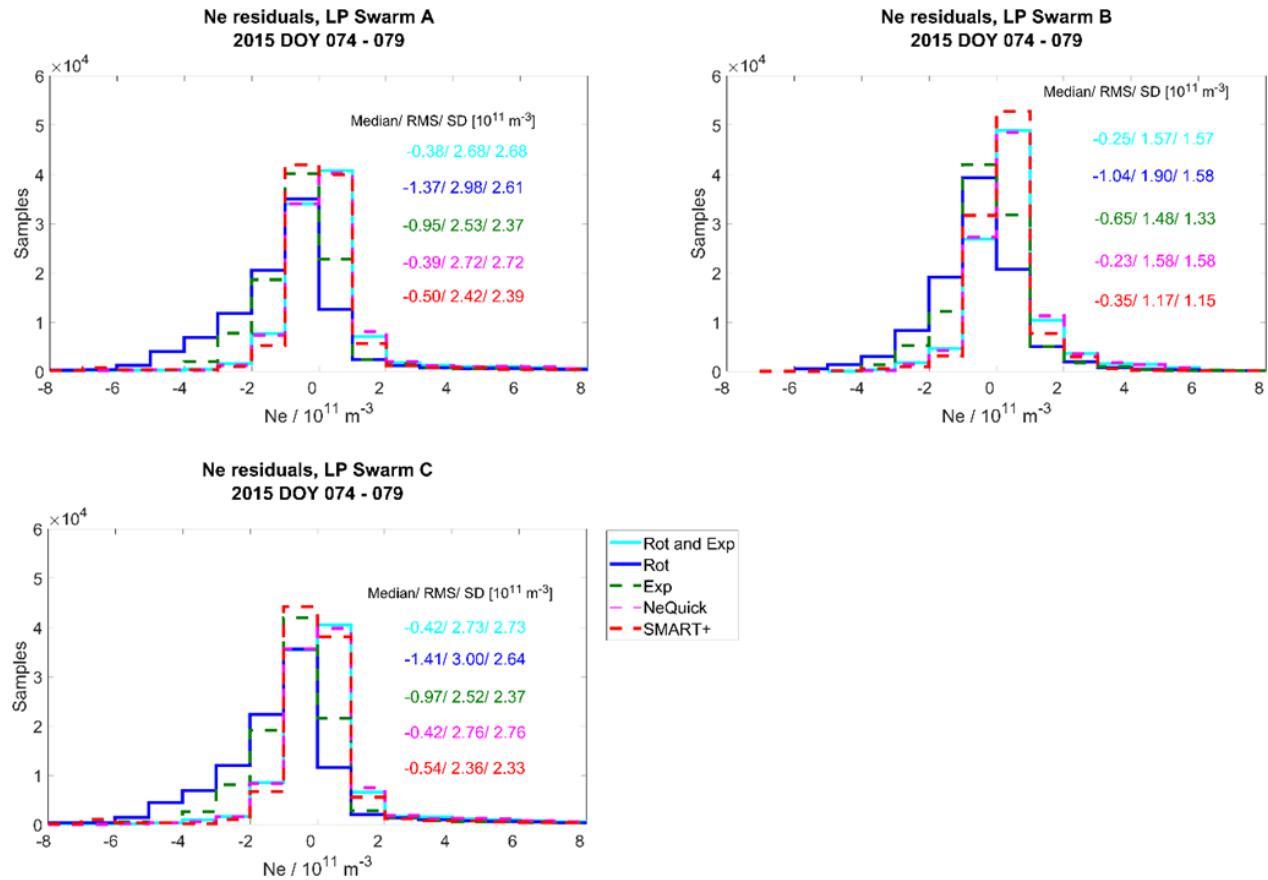
Figure 19. Validation with LP data. Distribution of the Swarm A, B and C (separated) electron density residuals for the perturbed period.